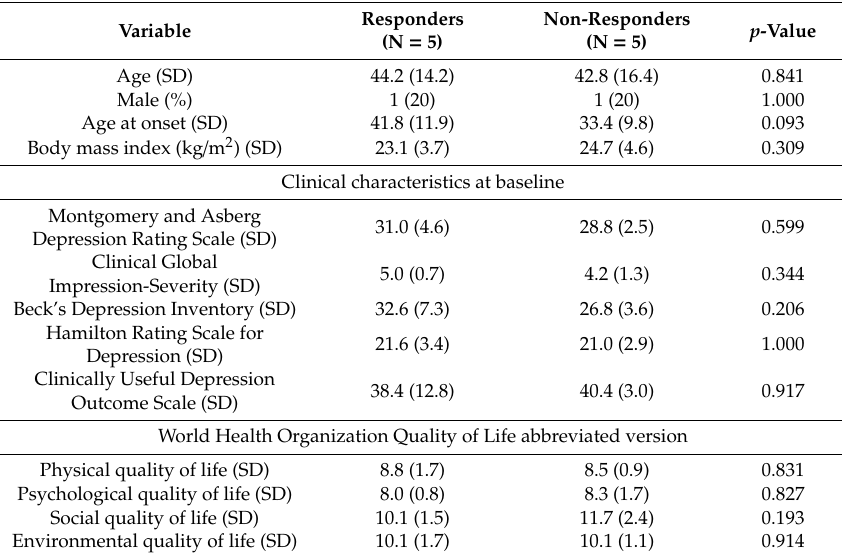
Table 1. Demographic and clinical variables of study